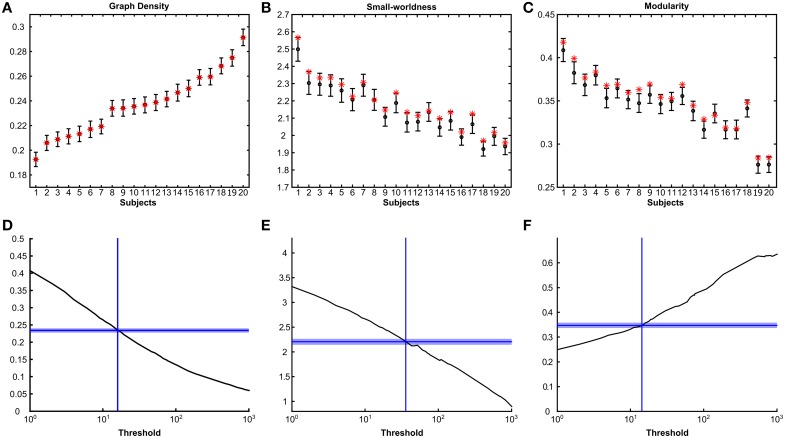
Posterior densities and point estimates of graph measures. Top panels show mean and 95% highest posterior density intervals (HPD) for graph density (A), small-worldness (B) and modularity (C) for all subjects sorted by their mean posterior graph density. Point estimates for thresholded graphs are indicated with red stars. Bottom panels (D–F) show the same graph measures as a function of streamline threshold for one subject (subject 8). Only thresholds resulting in connected graphs are shown. Horizontal dashed lines indicate the mean posterior estimate and the shaded areas cover the 95% HPD interval.